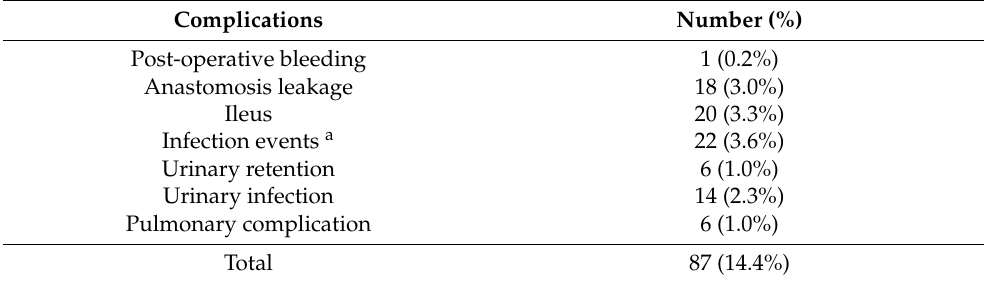
Table 3. Postoperative complications of 605 patients with rectal cancer undergoing robotic-assisted rectal surgery.